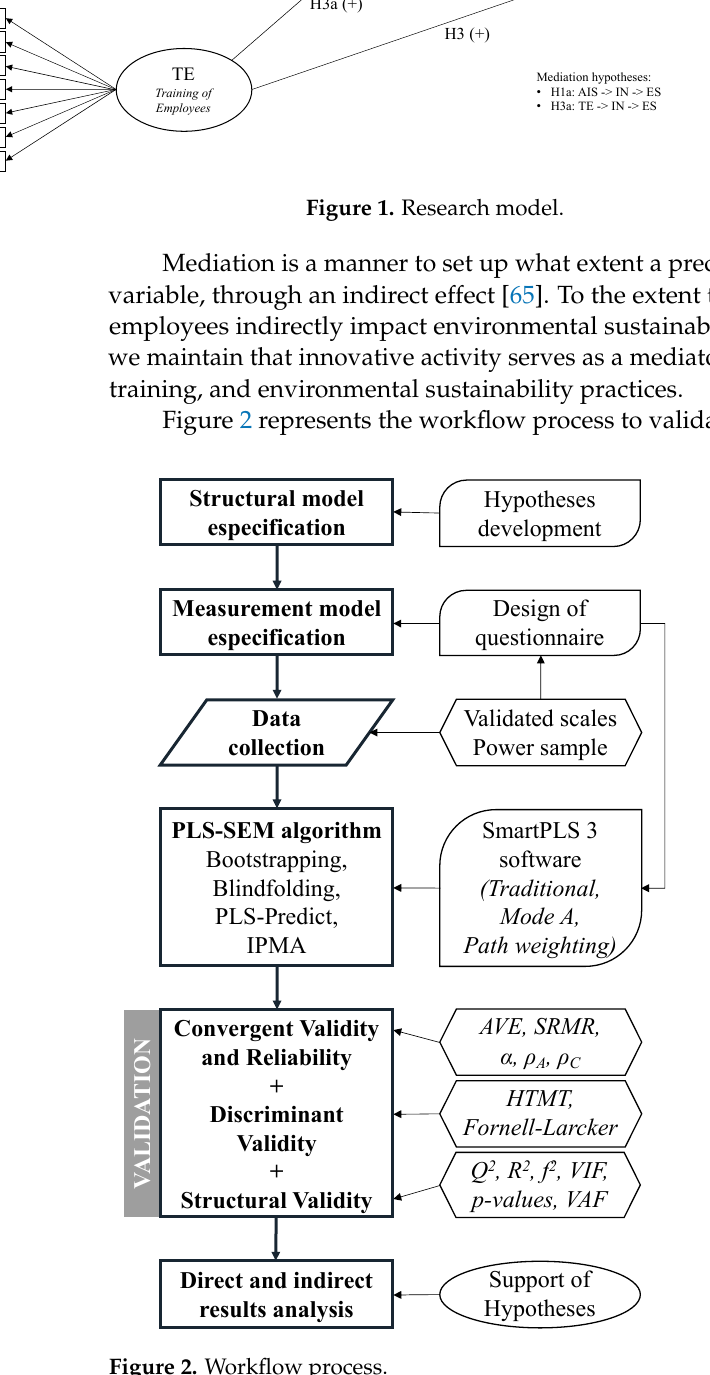
Figure 2. Workflow process.